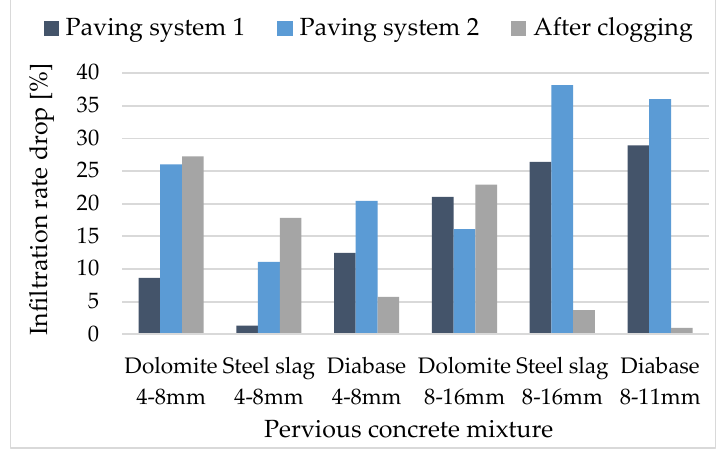
Figure 8. Results of an infiltration rate drop for single-sized mixtures.